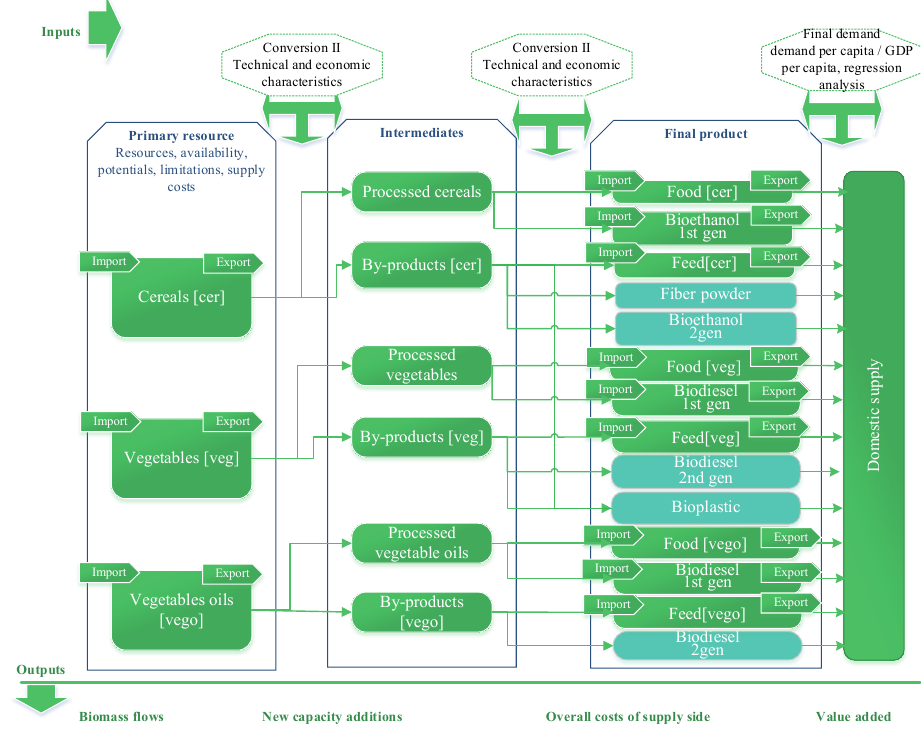
Fig. 1. Defined model boundaries for TIMES